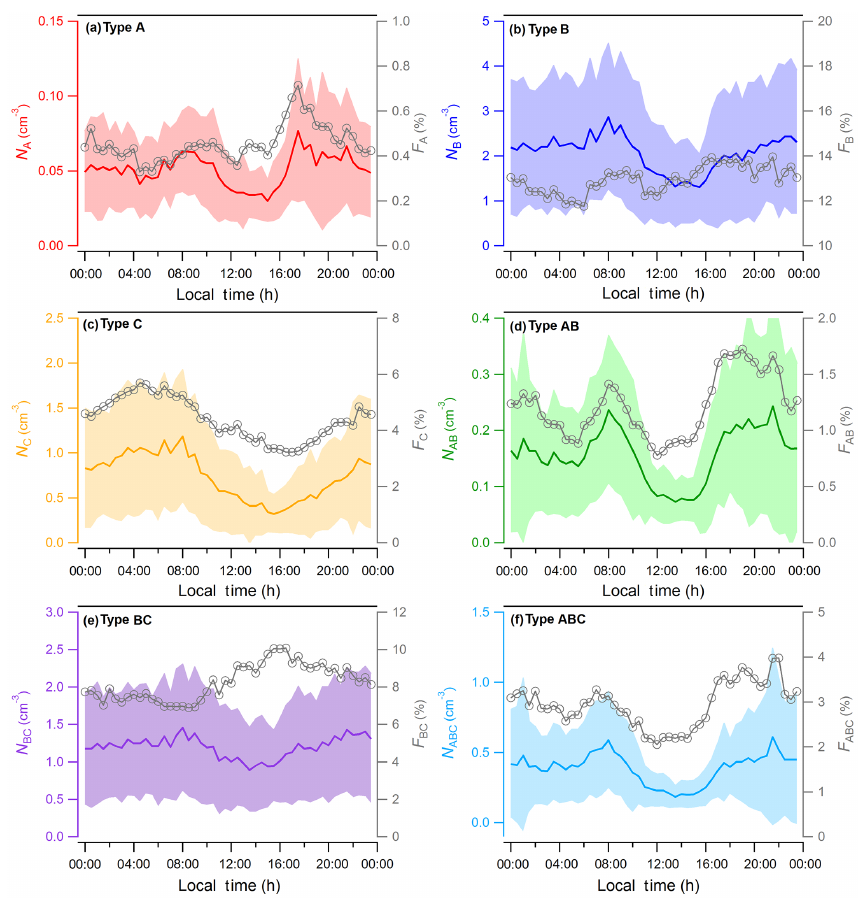
Figure 5. Diurnal variations of number concentrations of (a) type A (red), (b) type B (blue), (c) type C (dark yellow), (d) type AB (green), (e) type BC (purple), and (f) type ABC (light blue). Gray line indicates the number fraction of respective fluorescent particles (right axis). Shading indicates ± 1 standard deviation.